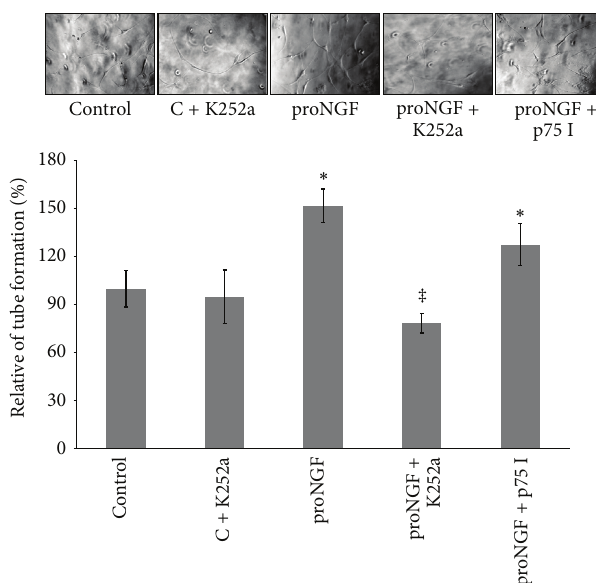
Figure 7: Inhibiting TrkA prevents proNGF-mediated retinal endothelial cell tube formation. BRE cells were grown into con- fluence and then trypsinized and mixed with reduced-growth factor Matrigel and treated with mutant proNGF (50ng/mL) in the presence or absence of either TrkA receptor antagonist, K252a (0.1 𝜇 M), or p 75 NTR inhibitor (20 𝜇 M). Representative micrographs for alignment of BRE into tube-like structures are shown after 18 hrs ofincubation.StatisticalanalysisoftubelengthshowedthatproNGF increased mean tube formation 1.5-fold compared to the control group. This effect was blocked by the specific TrkA receptor antag- onist (K252a) but not with p75 inhibitor ( ∗,‡ statistically significant compared to control and proNGF groups, resp., ( 𝑃 < 0.05 ), 𝑛 = 6